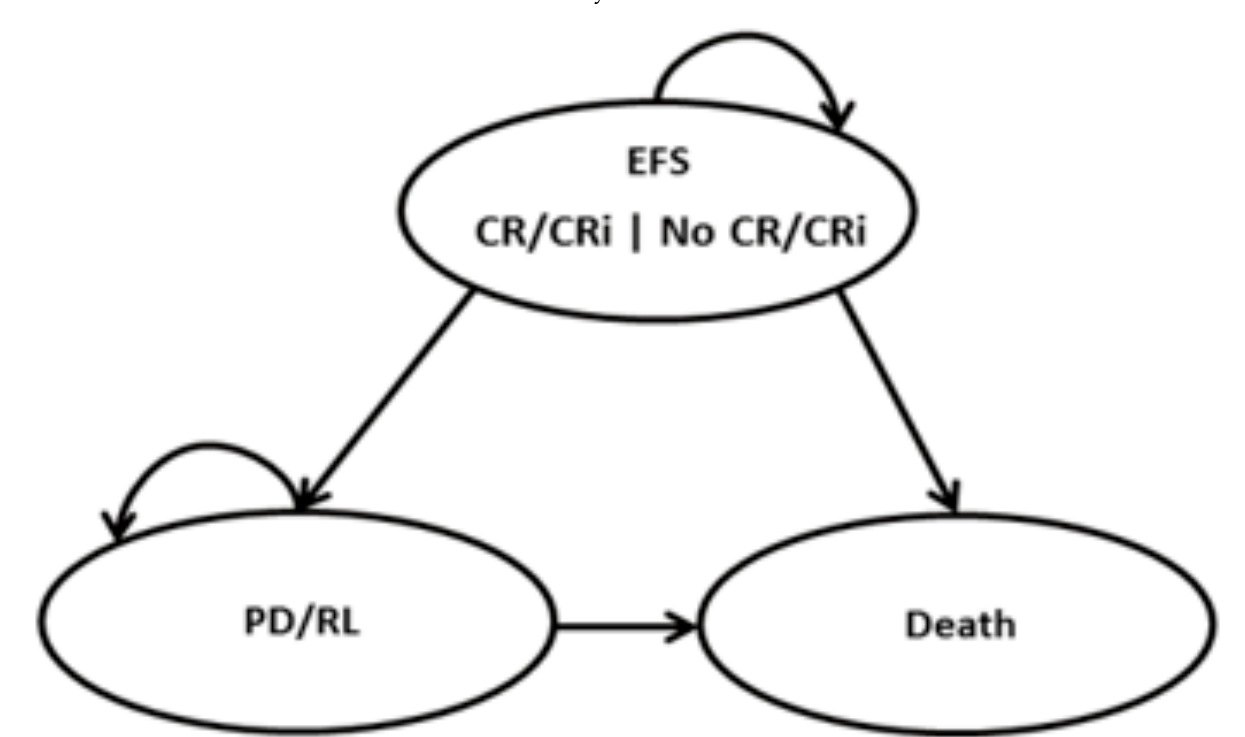
Figure 1. Partitioned survival model structure. EFS: Event-free survival, CR/CRi: complete remission/complete remission with incomplete blood count recovery, and PD/RL: progressive/relapsed dis ‐ ease.